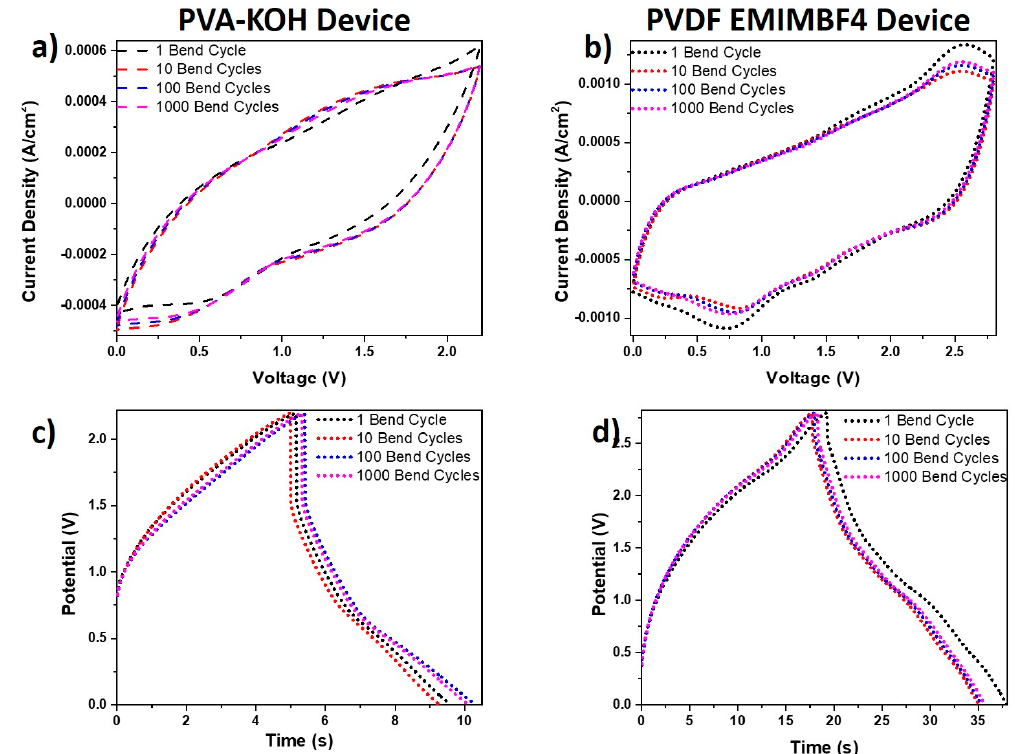
Figure 10. Cyclic voltammetry curves at a scanning rate of 200 mV/s obtained over multiple cycling bending up to 180 degrees for ( a ) the PVA-KOH device and ( b ) the PVDF-EMIMBF4 device. Charge-discharge graphs at a current density of 0.5 mA/cm 2 obtained over multiple bending cycles for ( c ) the PVA-KOH device and ( d ) the PVDF-EMIMBF4 device.